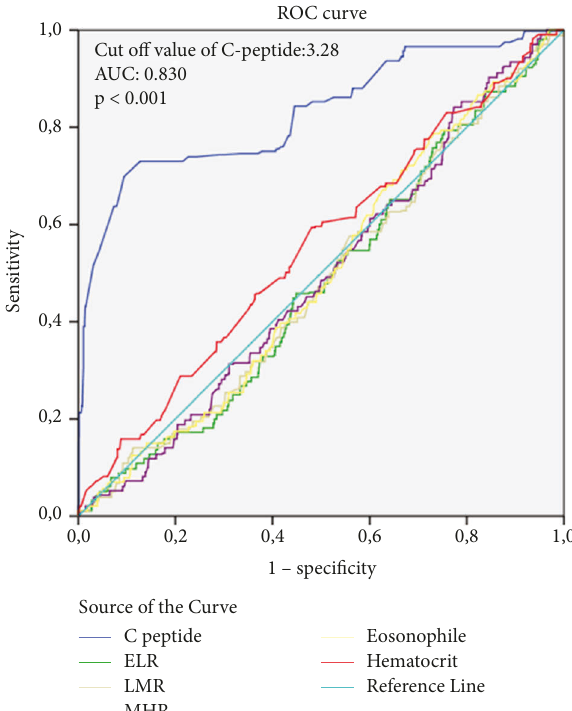
Figure 4: ROC curve analysis. ROC curve analysis showed that at a cut-off of 3.28ng/dl, the value of C-peptide exhibited 76% sensitivity and